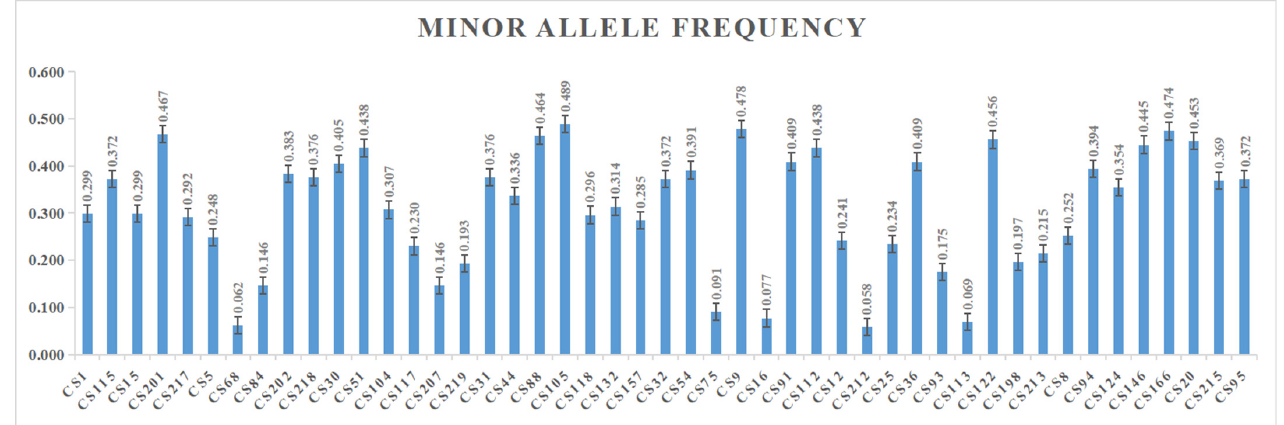
Figure 2. Minor allele frequency of 47 polymorphic SNP markers. Table 3. Genotypic DNA fingerprinting of tea germplasms based on SNP arrays (showing truncated spectra of 20 loci of 22 samples).